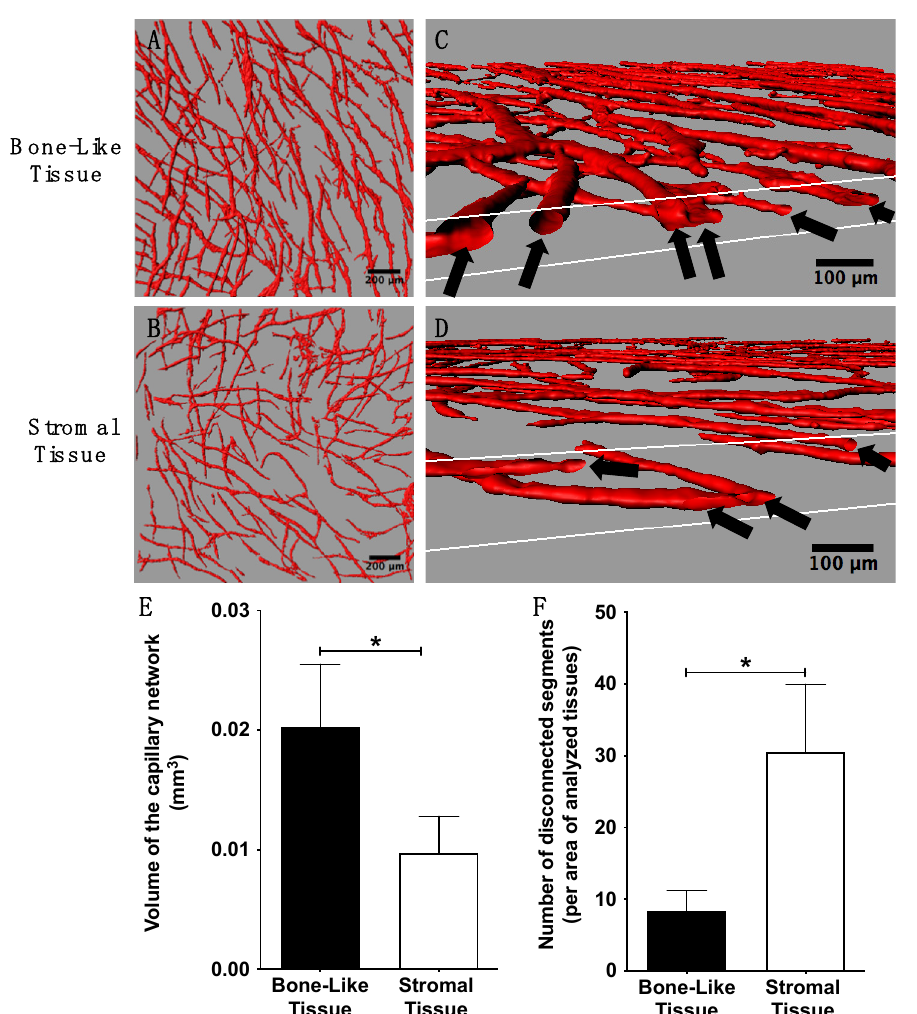
Figure 4. Characterization of the capillary network in reconstructed tissues two weeks after the seeding of endothelial cells. Three-dimensional reconstructions of CD31 positive structures (red) using Imaris ® software ( A – D ). Top views of the 3D reconstructions show greater capillary network density in bone-like tissues ( A ) compared to stromal tissues ( B ). Scale bars, 200 µm. Cross-sectional views of the 3D capillary networks revealed the presence of capillary lumens (black arrows) ( C ) and ( D ). Scale bars, 100 µm. Evaluation of the 3D reconstructed capillary network showing that bone-like tissues, when compared to stromal tissues, featured a significantly larger tissue volume occupied by CD31 positive structures ( E ), as well as a more connected capillary network, as shown by the lower number of disconnected components ( F ). Unpaired t tests, * p < 0.05.